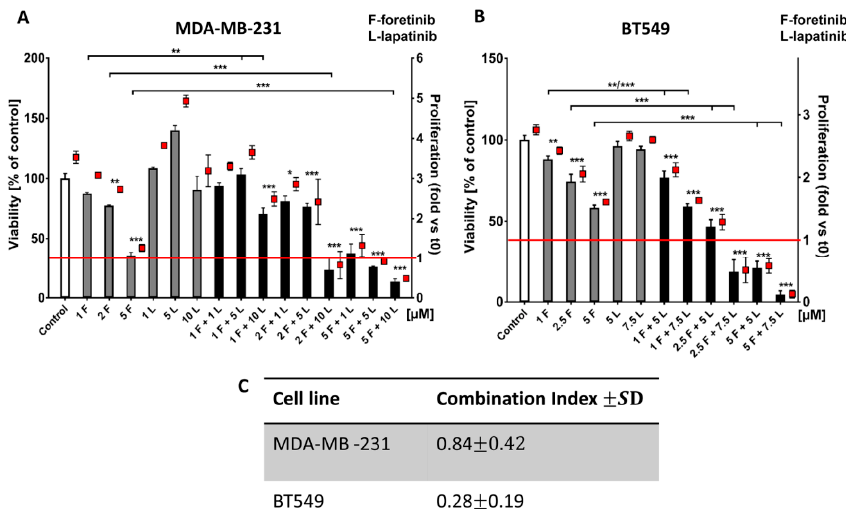
Figure A1. Effects of foretinib, lapatinib, and their combination on TNBC cell line viability and proliferation. Cell viability and proliferation was measured using an XTT assay (as discussed in the methods section). Cells were seeded on a layer of polymerized collagen. EGF and HGF was present in all conditions. Viability and proliferation of ( A ) MDA-MB-231 cells and ( B ) BT549 cells after 48 h incubation with the indicated concentrations of inhibitors (in µ M) were compared to those of control cells (percentage of viable cells versus control cells with the control set to 100 or proliferation-based fold change versus the control). Results, which are expressed as the mean ± SD, are based on at least three independent experiments. The statistical significance was assessed versus the control. The significance level was set at p ≤ 0.05 (*), p ≤ 0.01 (**), or p ≤ 0.001 (***). ( C ) The combination index after 48 h of drug treatment was determined. Drug combinations in which CIs were <1.0 were considered to be